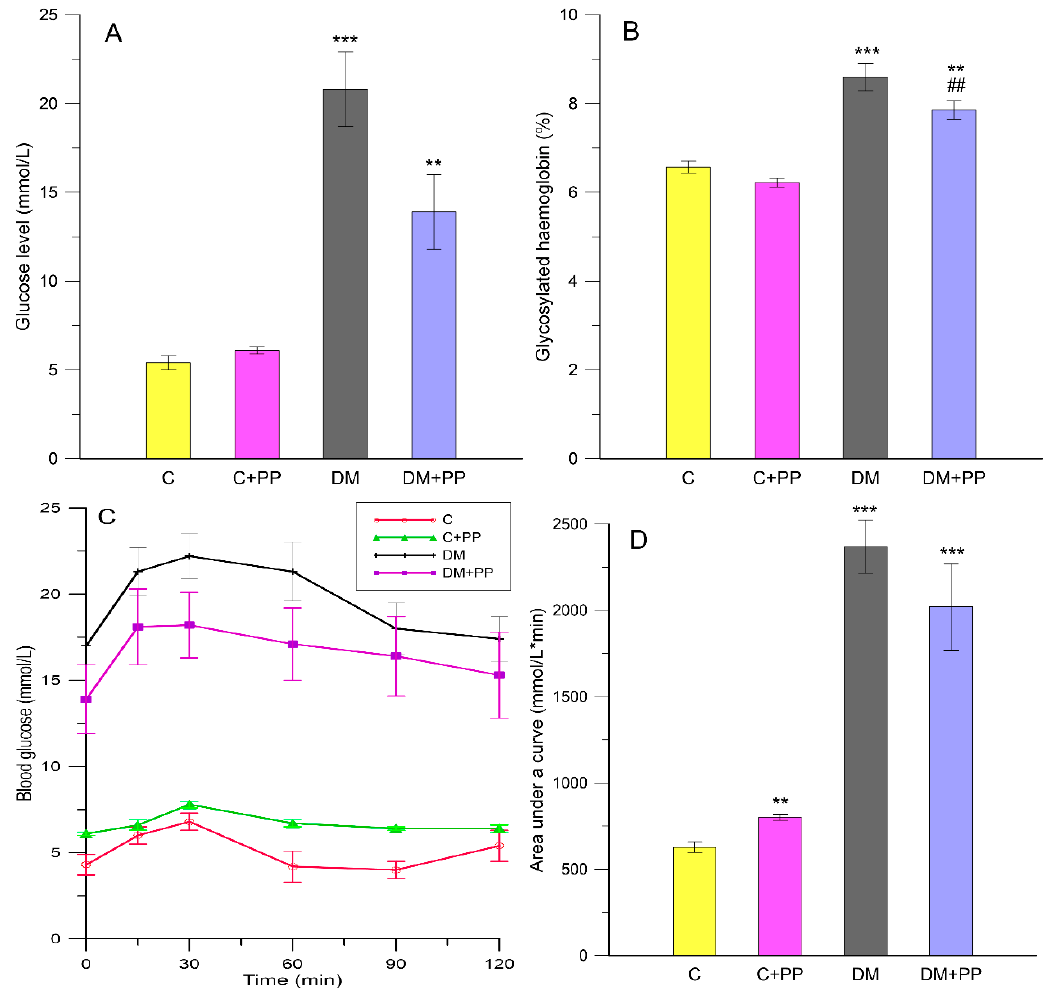
Figure 1. Glucose-related parameters under administration of purple potato (PP) extract from Blue Congo variety: ( A ) fasting blood glucose; ( B ) glycated hemoglobin, % of total hemoglobin; ( C ) oral glucose tolerance test; ( D ) area under the curve after glucose load of rats. C—control group, C + PP—control rats receiving extract from Blue Congo (daily dose of 165 mg/kg body weight (b.w.) for 14 days), diabetes mellitus (DM)—diabetic group, DM + PP—diabetic rats treated with Blue Congo extract (daily dose of 165 mg/kg b.w. for 14 days). Results are shown as means ± SD. Significance was measured using one-way analysis of variance (ANOVA). Designations: ** p < 0.01, *** p < 0.001 compared to the control group; ## p < 0.01 compared to the DM group.